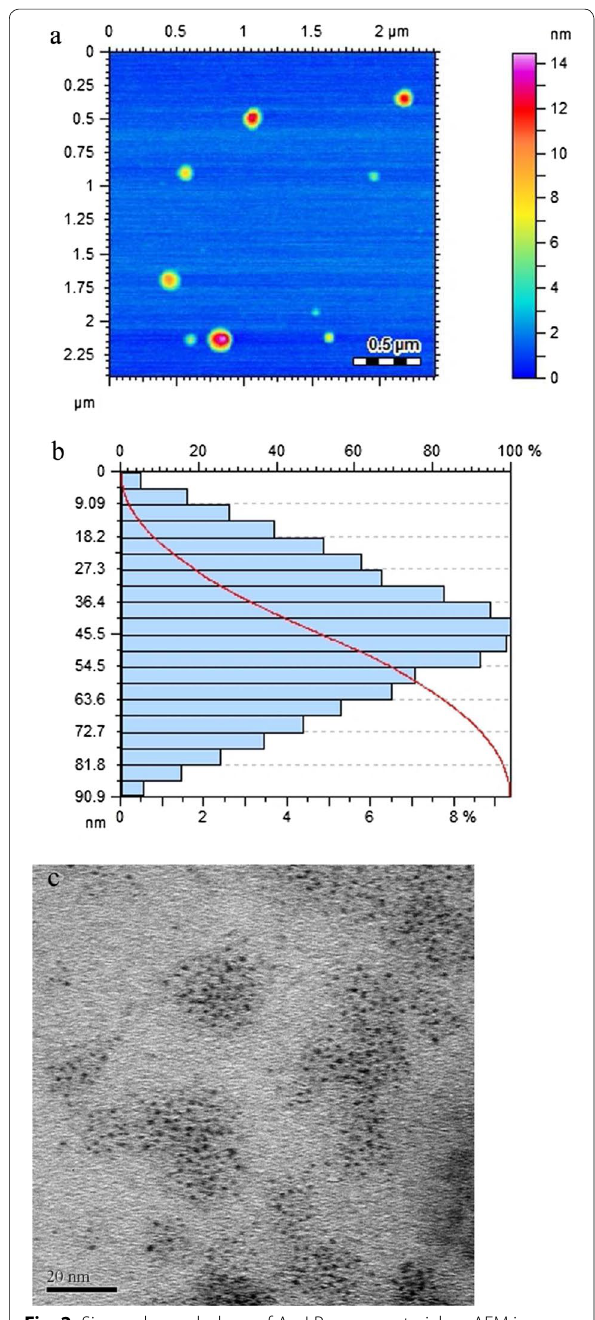
Fig. 2 Size and morphology of Au-LPa nanomaterials. a AFM image of Au-LPa large. b Size distribution histogram of Au-LPa large. c TEM image of Au-LPa